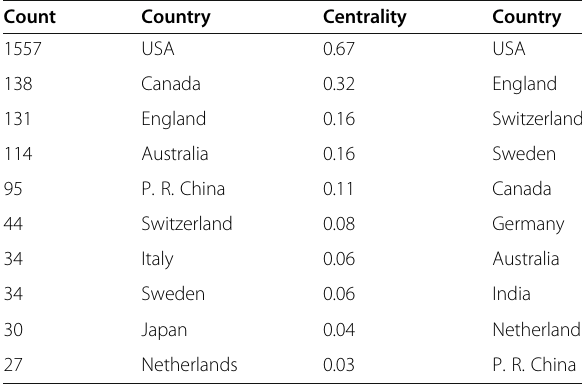
Table 1 Top 10 countries in the count and centrality of international database